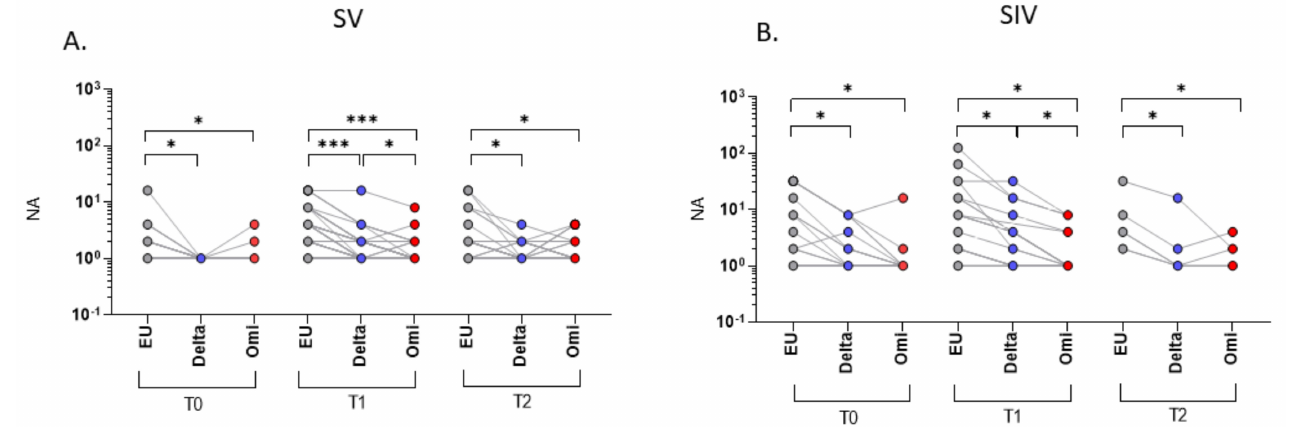
Figure 5. Saliva neutralizing activity (NA) correlations among different VOCs. NA correlation performed at different time points (T0, T1, and T2) showed higher NA against the EU variant compared to the Delta and Omicron (Omi) variants in plasma samples from both SARS-CoV-2 Vaccinated subjects (SV) ( A ) and SARS-CoV-2 Infected and Vaccinated subjects (SIV) ( B ). Lines connect the NA of each subject. * p < 0.05, *** p < 0.001.